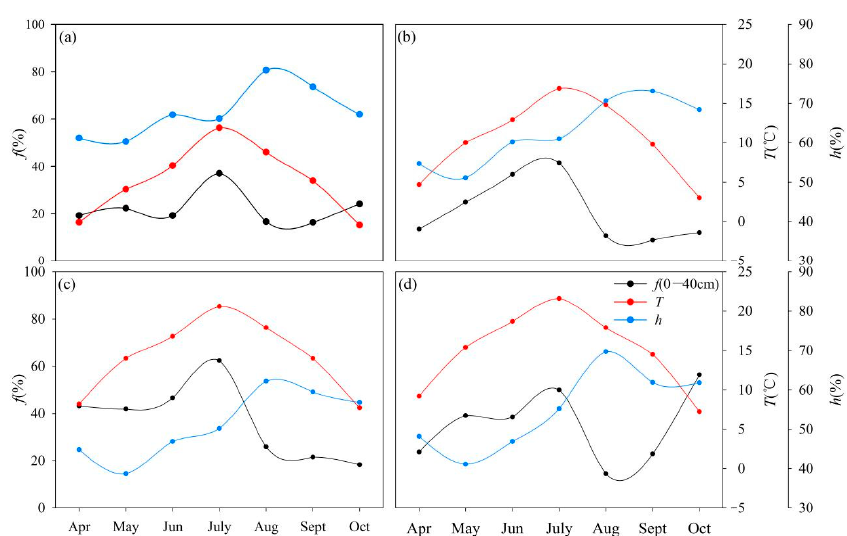
Figure 8. Changes in temperature, relative humidity, and 0 to 40 cm mean value of evaporation loss f at the four stations during the observation period (( a ) Lenglong; ( b ) Ningchan; ( c ) Huajian; ( d ) Xiying).